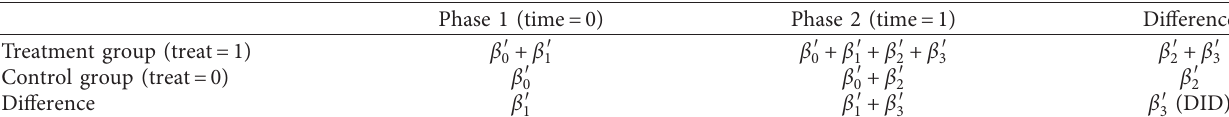
Table 3: The calculation principle of